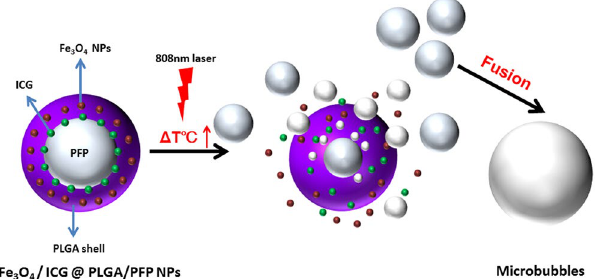
Figure 1. Schematic illustration of the structure of Fe 3 O 4 /ICG@PLGA/PFP NPs and the progress of the generation of mircobubbles from within the NPs via NIR-induced vaporization of PFP.